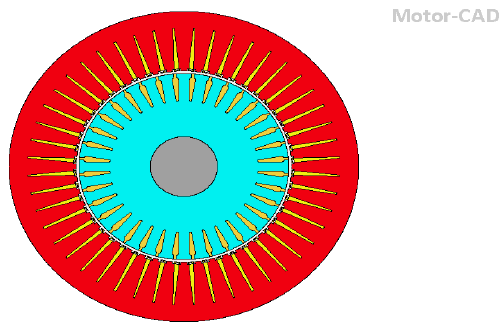
Figure 3. A Cross Section of Stator core and Rotor